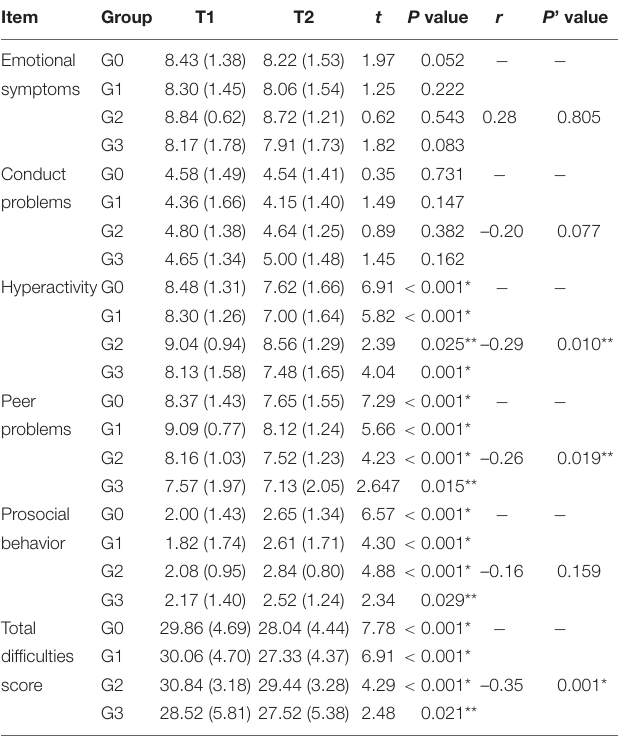
CARS, Childhood Autism Rating Scale. T1, pre-intervention; T2, post-intervention. G1, age 36–48-month in the intervention group; G1c, age 36–48-month in the control group. Data are expressed as the means (SD). *P < 0.01. TABLE 6 | Comparison of T1 and T2 SDQ scores of the intervention